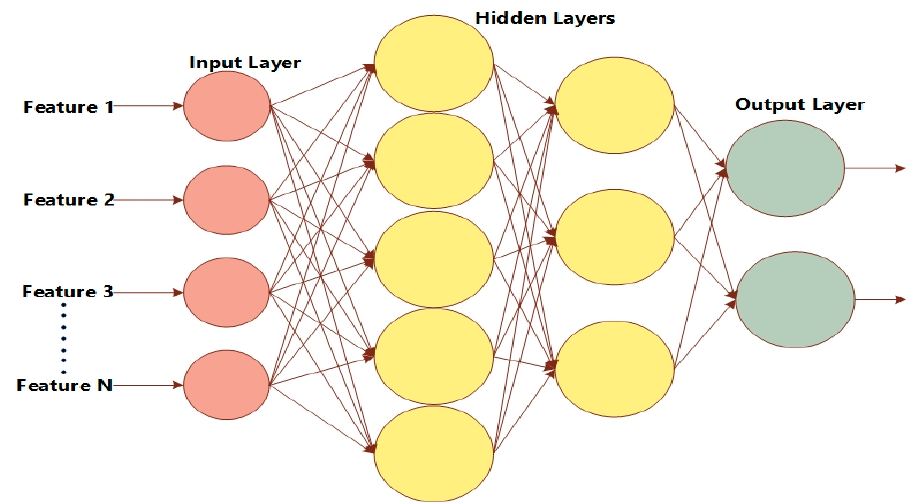
Some samples from the dataset.